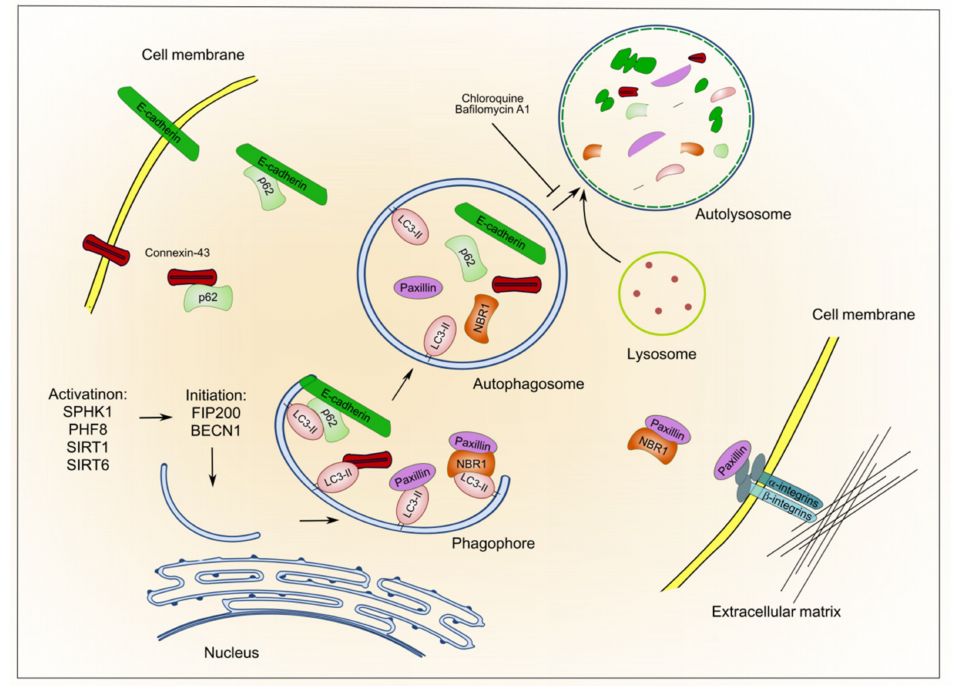
Figure 2. Autophagy-mediated degradation of cell adhesion molecules. The scheme reports only the molecules described in the